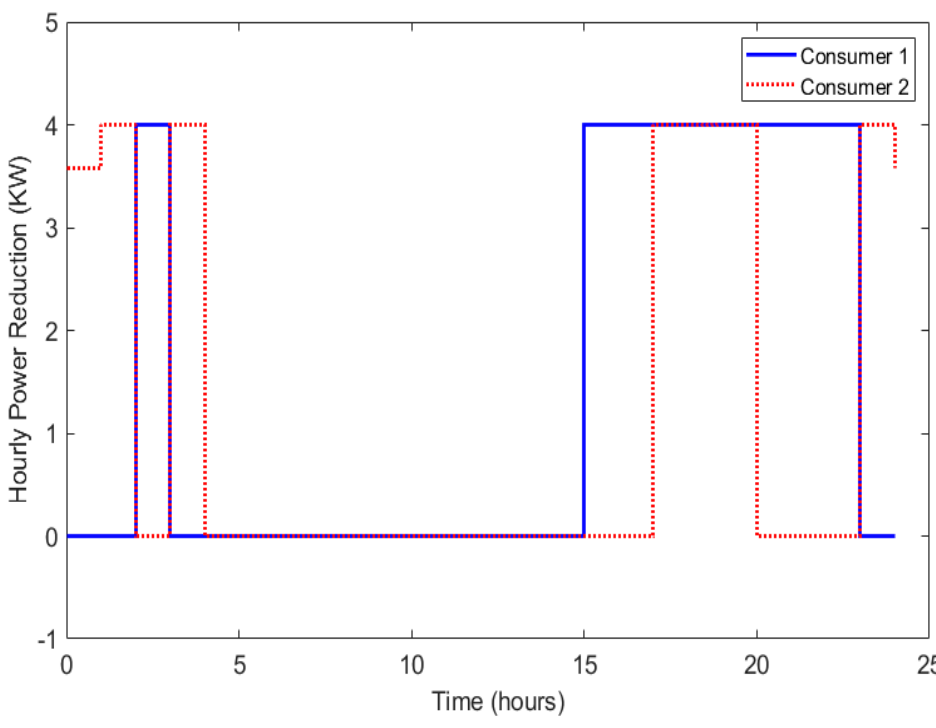
Figure 12. Hourly power reduction for each consumer.